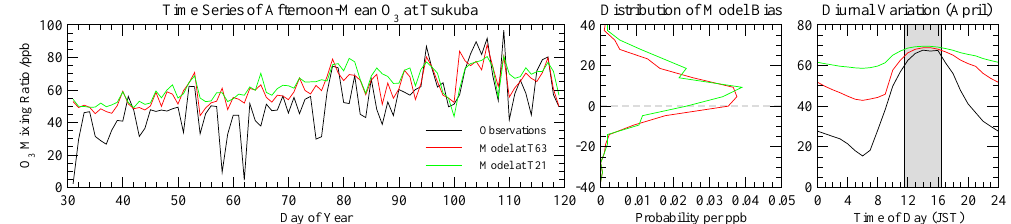
Fig. 3. Comparison of afternoon-mean O 3 observations (12:00–16:00h JST) at Tsukuba WMO/GAW station (black) with CTM results at T21 (green) and T63 (red) resolution. Right-hand panels show the distribution of the hourly model bias and the monthly mean diurnal variation in observed and modelled O 3 in April.